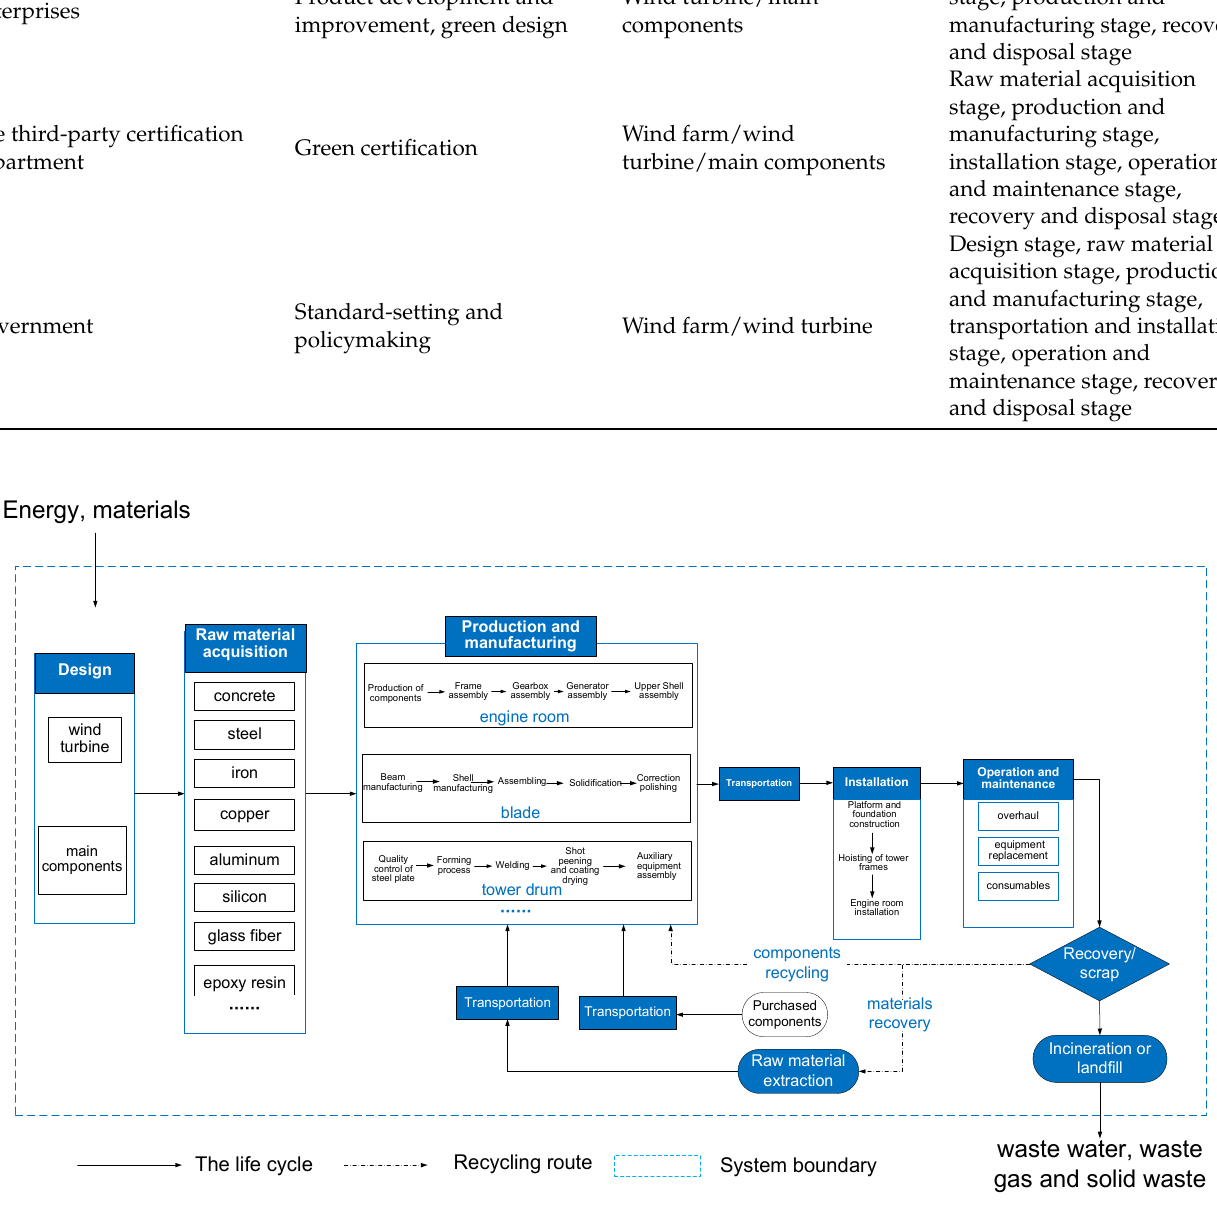
Figure 2. The boundary of the LCA system for the wind turbine.